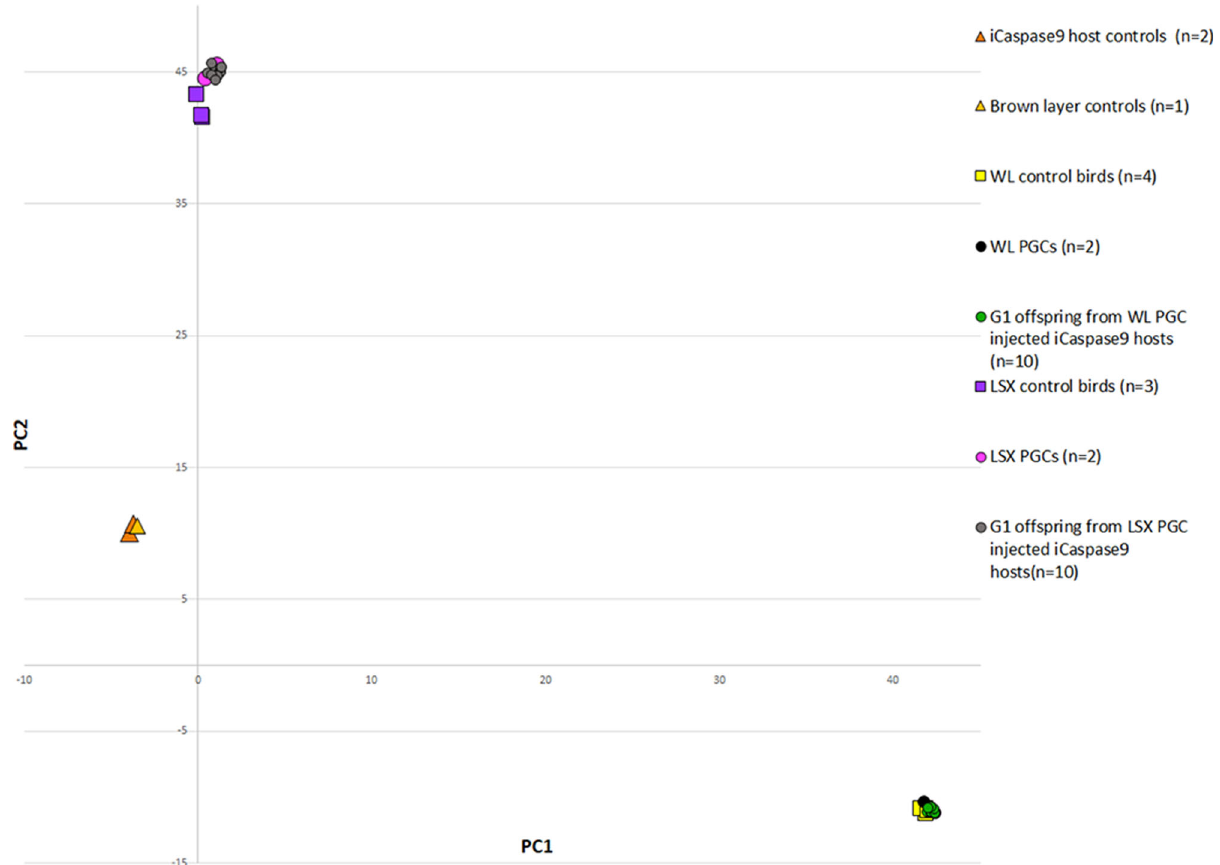
Fig. 4 PC analysis of G1 offspring from iCaspase9 surrogate host birds. DNA samples were genotyped on a 66 K SNP chip and analysed for PCs. Three chicken breeds were analysed: the brown layer breed which includes the iCaspase9 hosts, the LSX breed, and the WL Line 6 breed. Offspring from iCaspase9 hosts injected with LSX PGCs (grey) clustered with LSX control birds. Offspring from iCaspase9 surrogate hosts injected with WL Line 6 PGCs (green) clustered with WL Line 6 control